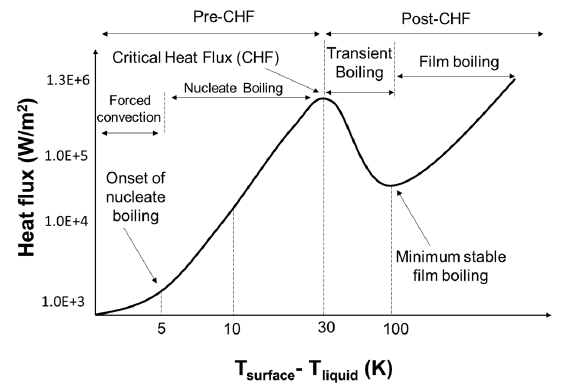
Figure 4. The boiling curve for water at atmospheric pressure.